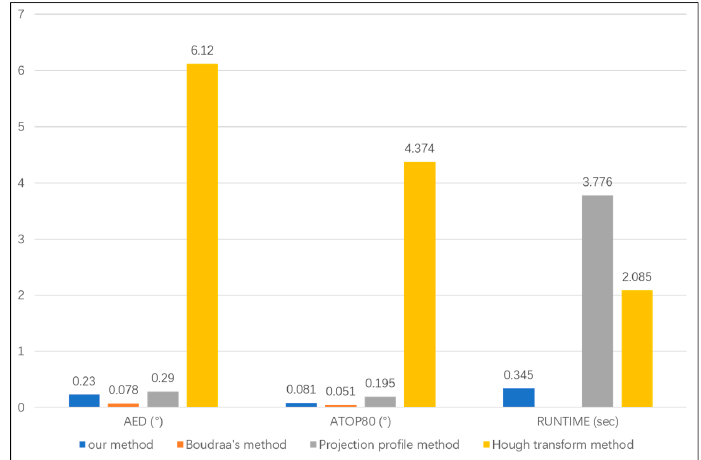
Figure 6. The average errors deviations over all tested images and over the best 80% of images, and the average runtime of them.